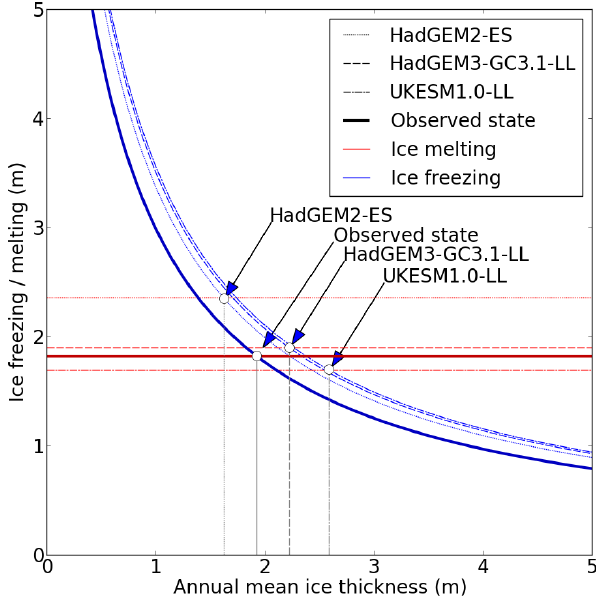
Figure 9. An illustration of idealised ice thickness and ice growth (blue line) and ice thickness and ice melt (red line) relationships in the evaluated models and in observations, as produced by the ISF parameterisation. The graph demonstrates how the ice growth and ice melt curves determine equilibrium ice thickness in each model